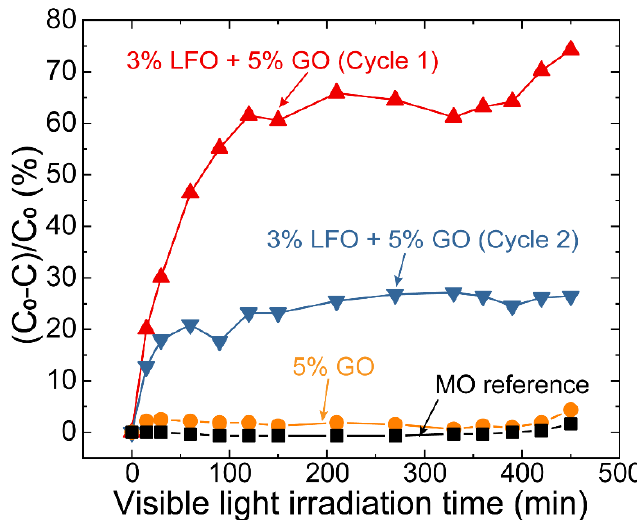
Figure 8. Photocatalytic degradation rate under visible light irradiation of MO for GO 5% and LFO 3% + GO 5%, after one and two degradation cycles.